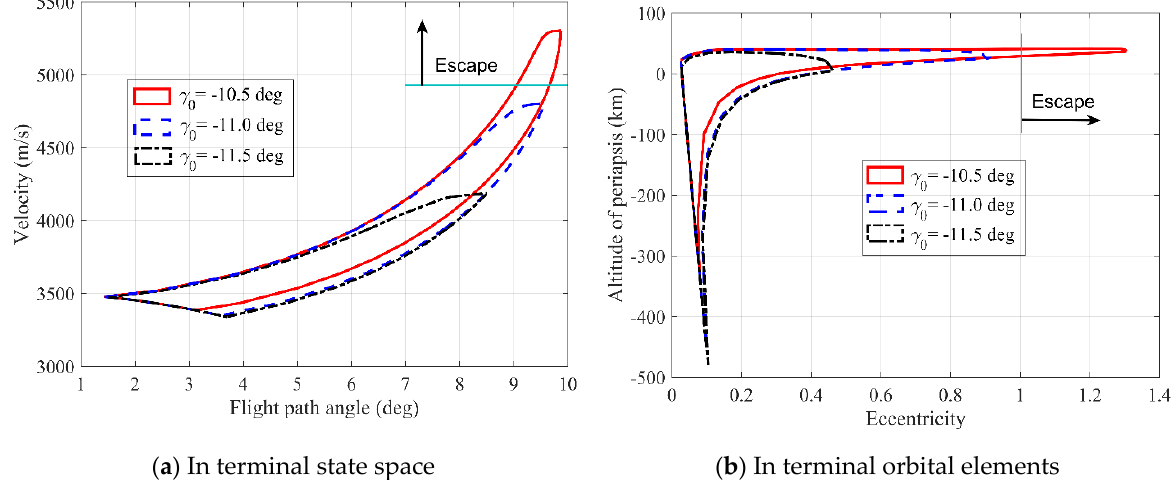
Figure 10. Aerocapture attainability sets with a different initial flight-path angle.